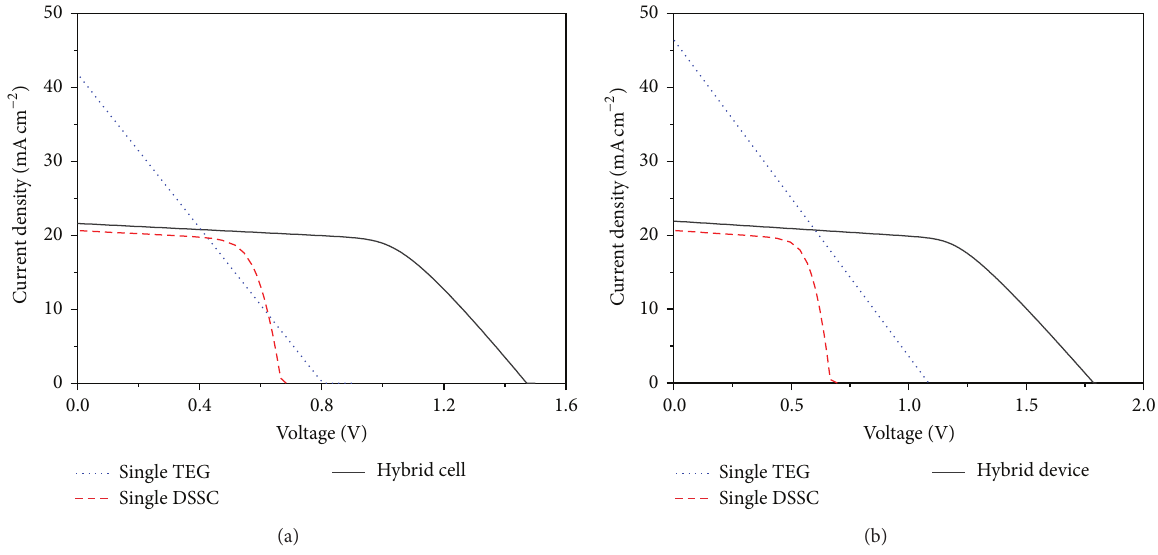
Figure 5: The 𝐽 - 𝑉 curves of TEG, DSSC, and hybrid device under simulated AM 1.5 solar spectrum irradiation at 100mWcm −2 with (a) 𝑑 = 15 𝜇 m and (b) 𝑑 = 30𝜇 m.